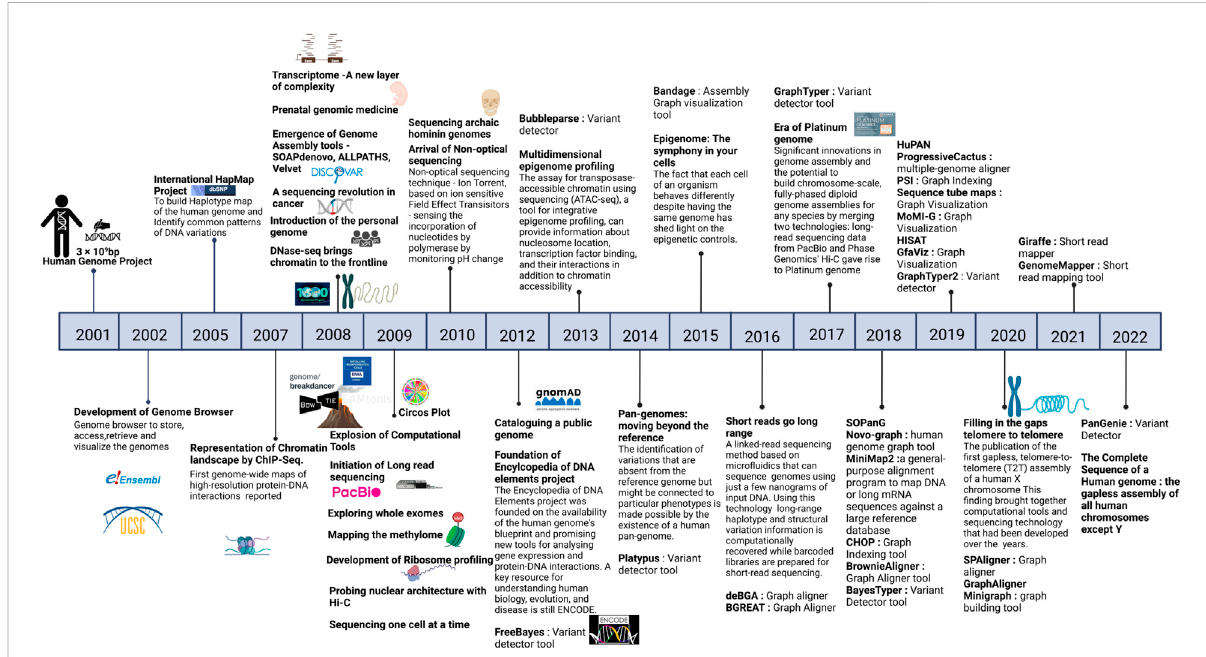
FIGURE 1 Timeline of major milestones in the last twenty years of human genomics. Created with BioRender.com.